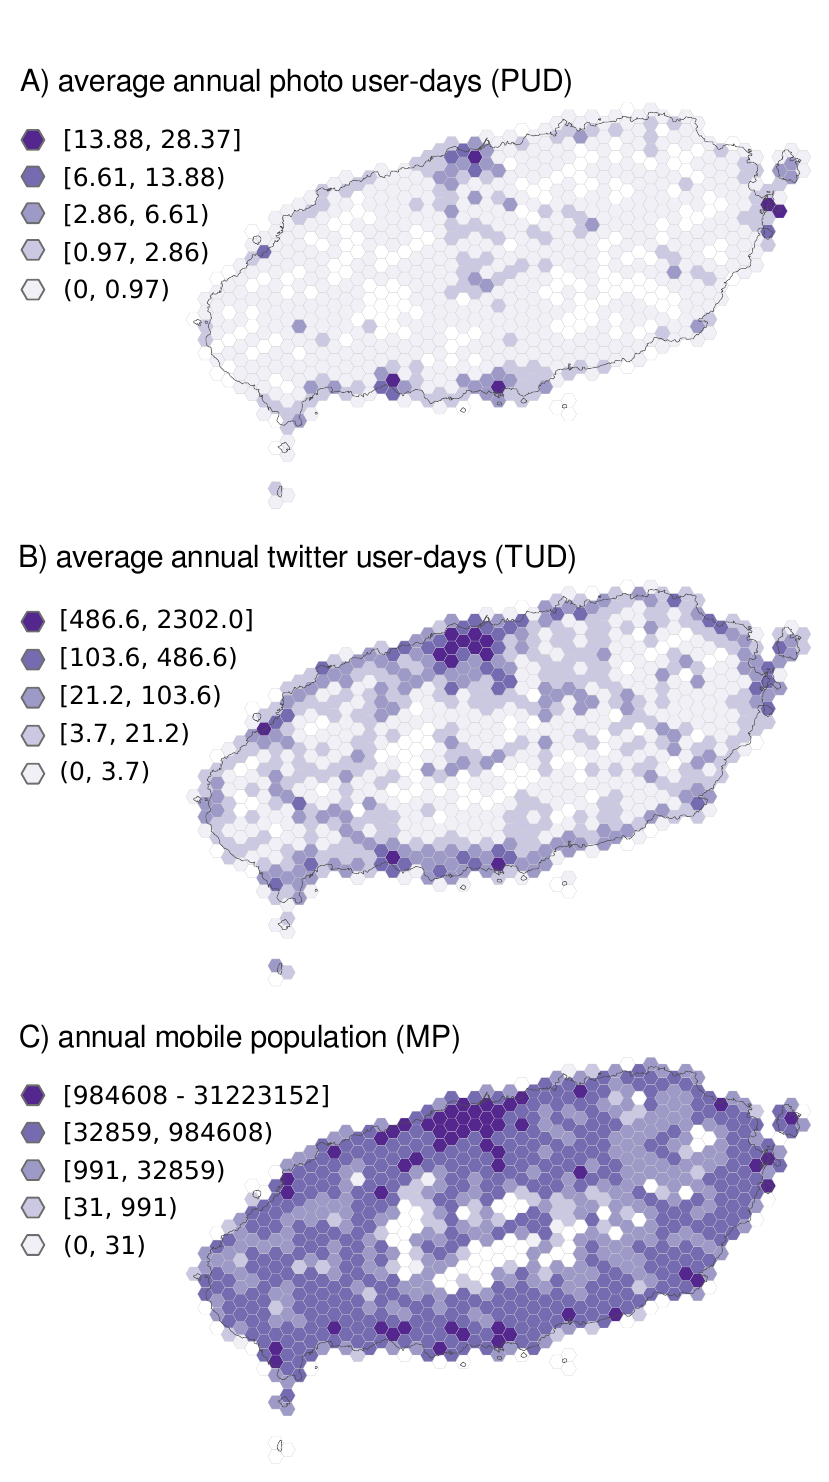
Figure 2. Maps show the variation in tourist visitation rate across Jeju Island, based on data from ( A ) photographs (PUD), ( B ) tweets (TUD), and ( C ) mobile-phone communications (MP), summarized in 2.6 km 2 cells. For each variable, positive values were log-transformed and then binned into five equal intervals for visualizing. Square brackets indicate closed intervals—the limit value is included. Parentheses indicate open intervals—the limit value is excluded. Values in the legends are untransformed. For ( A , B ) white cells indicate zeros, while in ( C ) white cells indicate no